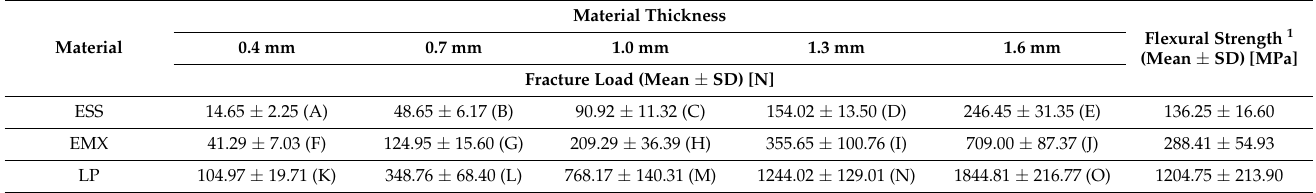
Figure 5. Regression curves of the fracture load values for the IPS e.max CAD LT A2 (EMX), with specimens in the five different material thicknesses examined.